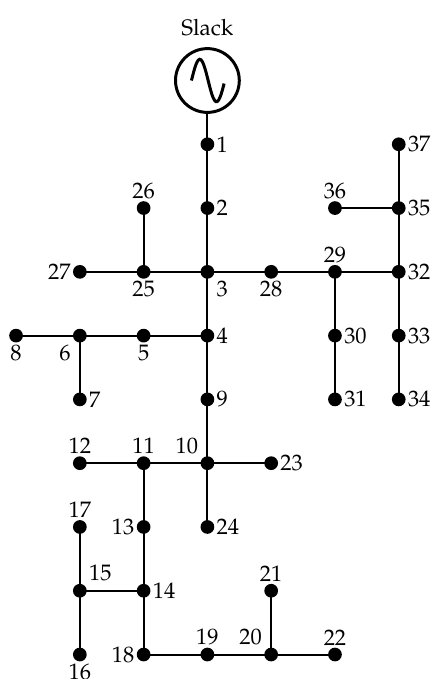
Figure 4. Nodal connection of the IEEE 37-bus